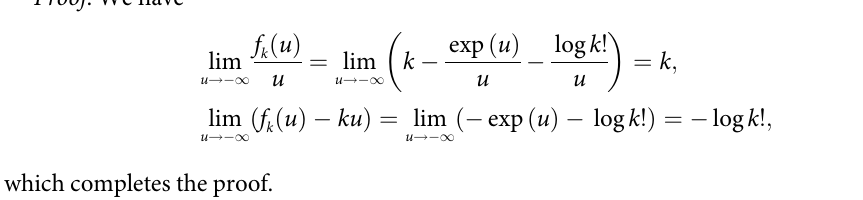
( u ) for k 2 {0, 5, 10, 15, 20}. k